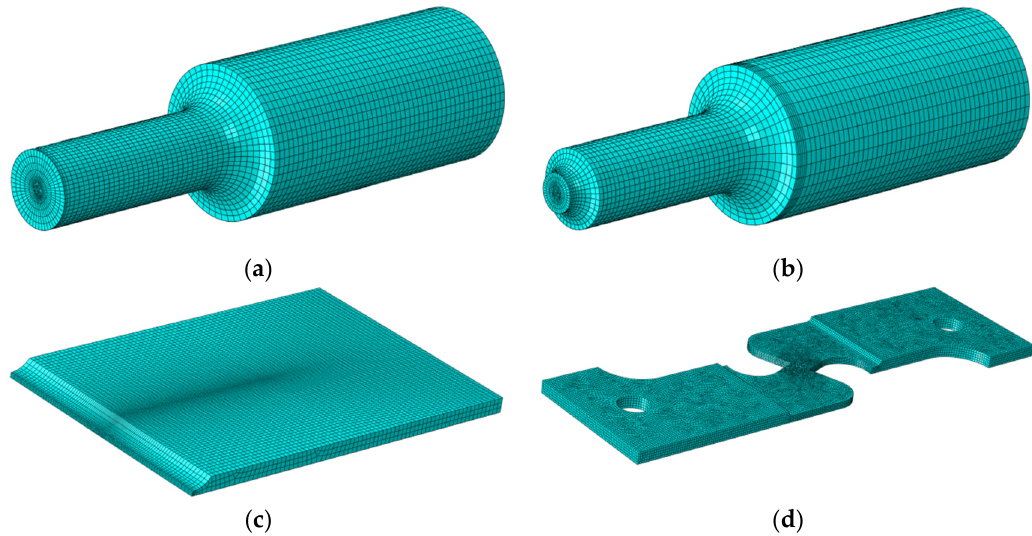
Figure 9. Finite element model of specimens: ( a ) smooth round bars, ( b ) notched round bars, ( c ) flat grooved plates, ( d ) tensile–shear flat plates.